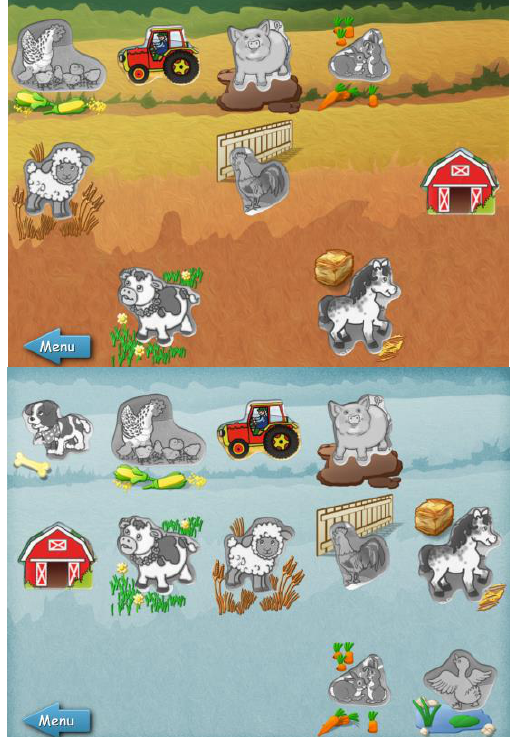
Figure 8. An indicative instance of the third level (Up) / An indicative instance of the fourth level